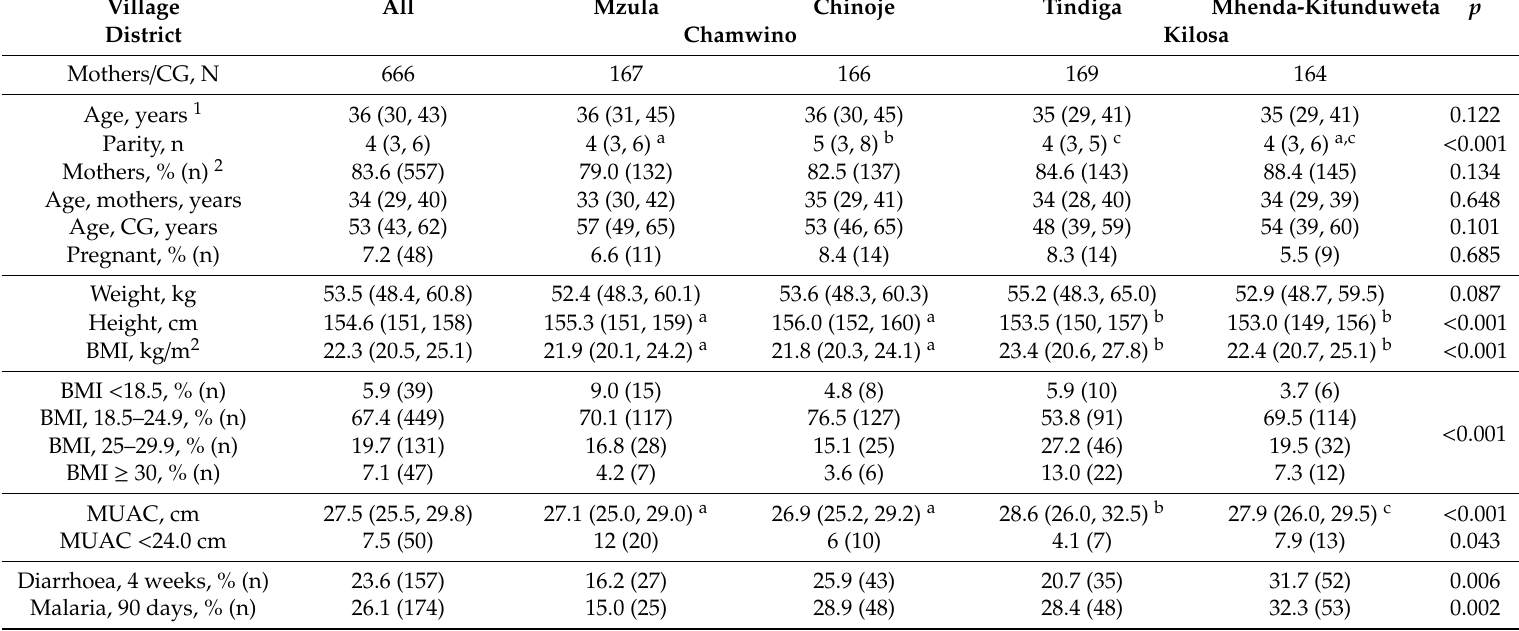
Table 1. Characteristics of the study population: mothers and caregivers (CG).